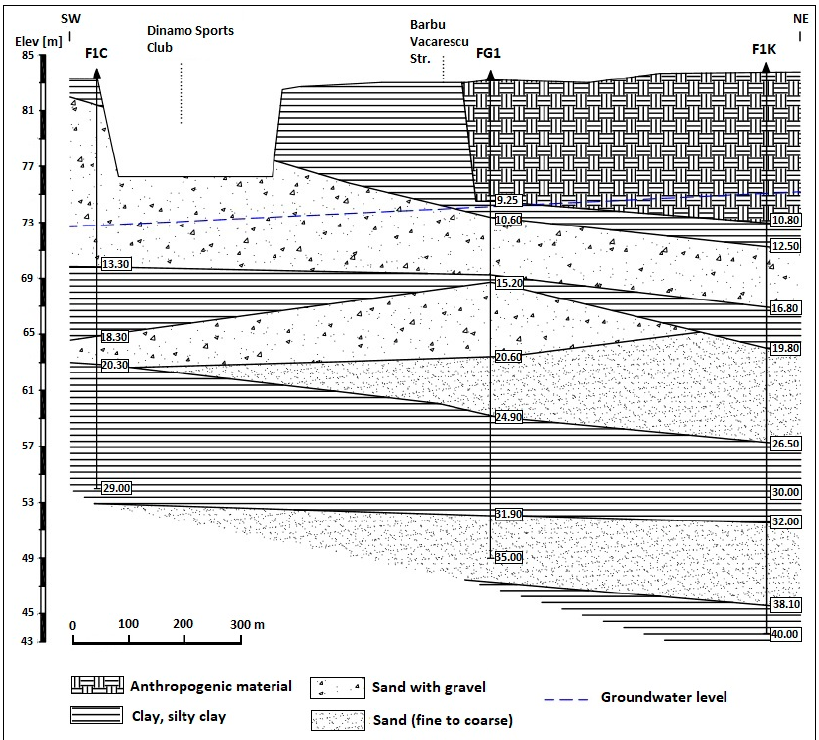
Figure 5. Geological cross ‐ section used to generate the geological model.